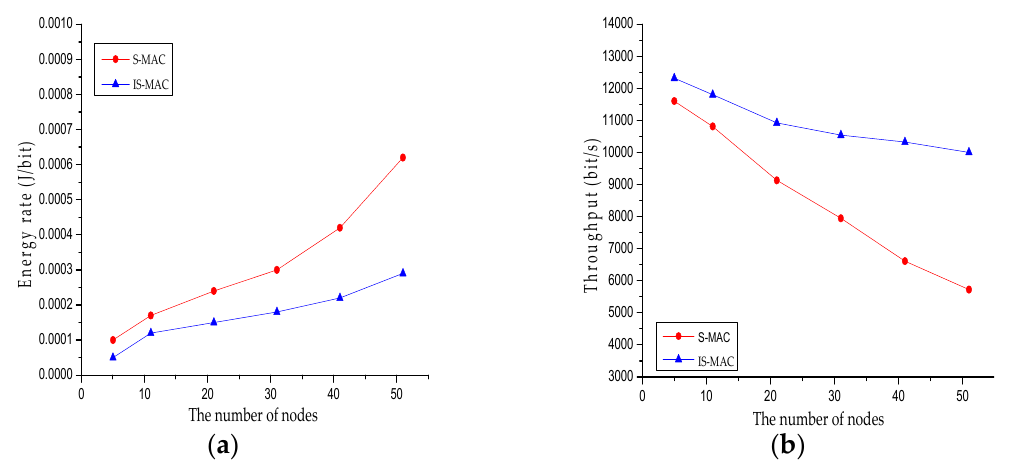
Figure 2. ( a ) Energy Rate of S-MAC protocol and IS-MAC protocol under different numbers of nodes; ( b ) throughput of S-MAC protocol and IS-MAC protocol under different numbers of dodes.